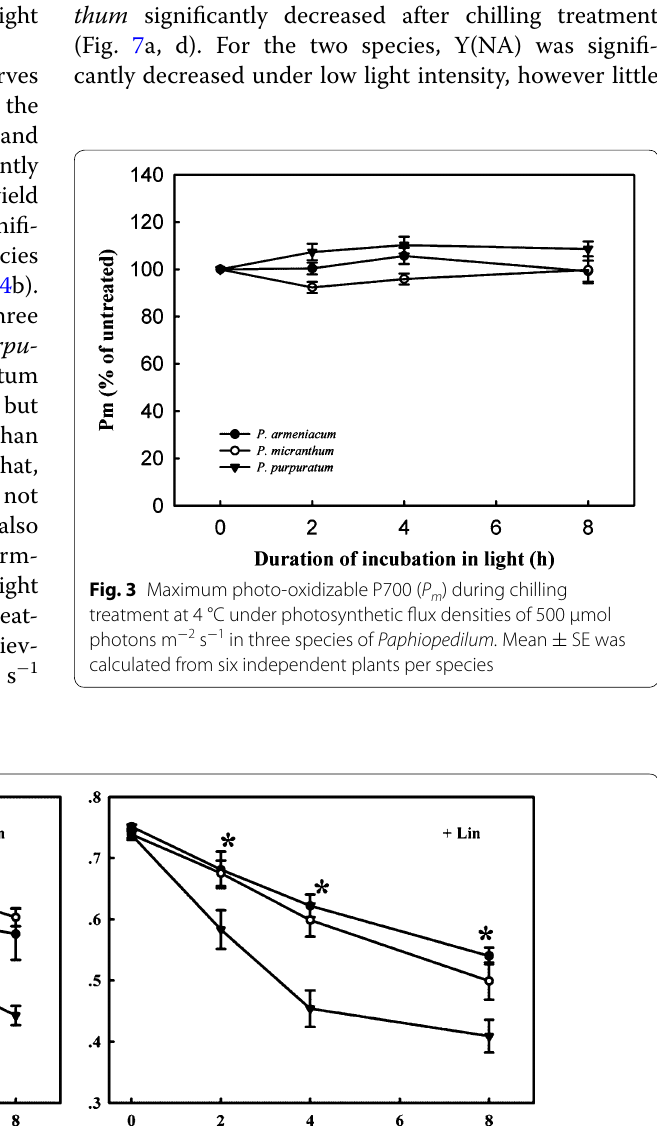
Fig. 2 Change in F v /F m in the three Paphiopedilum species during chilling treatment at 4 °C under photosynthetic flux densities of 500 μmol pho‑ tons m − 2 s − 1 in the presence and absence of lincomycin. Mean SE was calculated from six independent plants per species ±